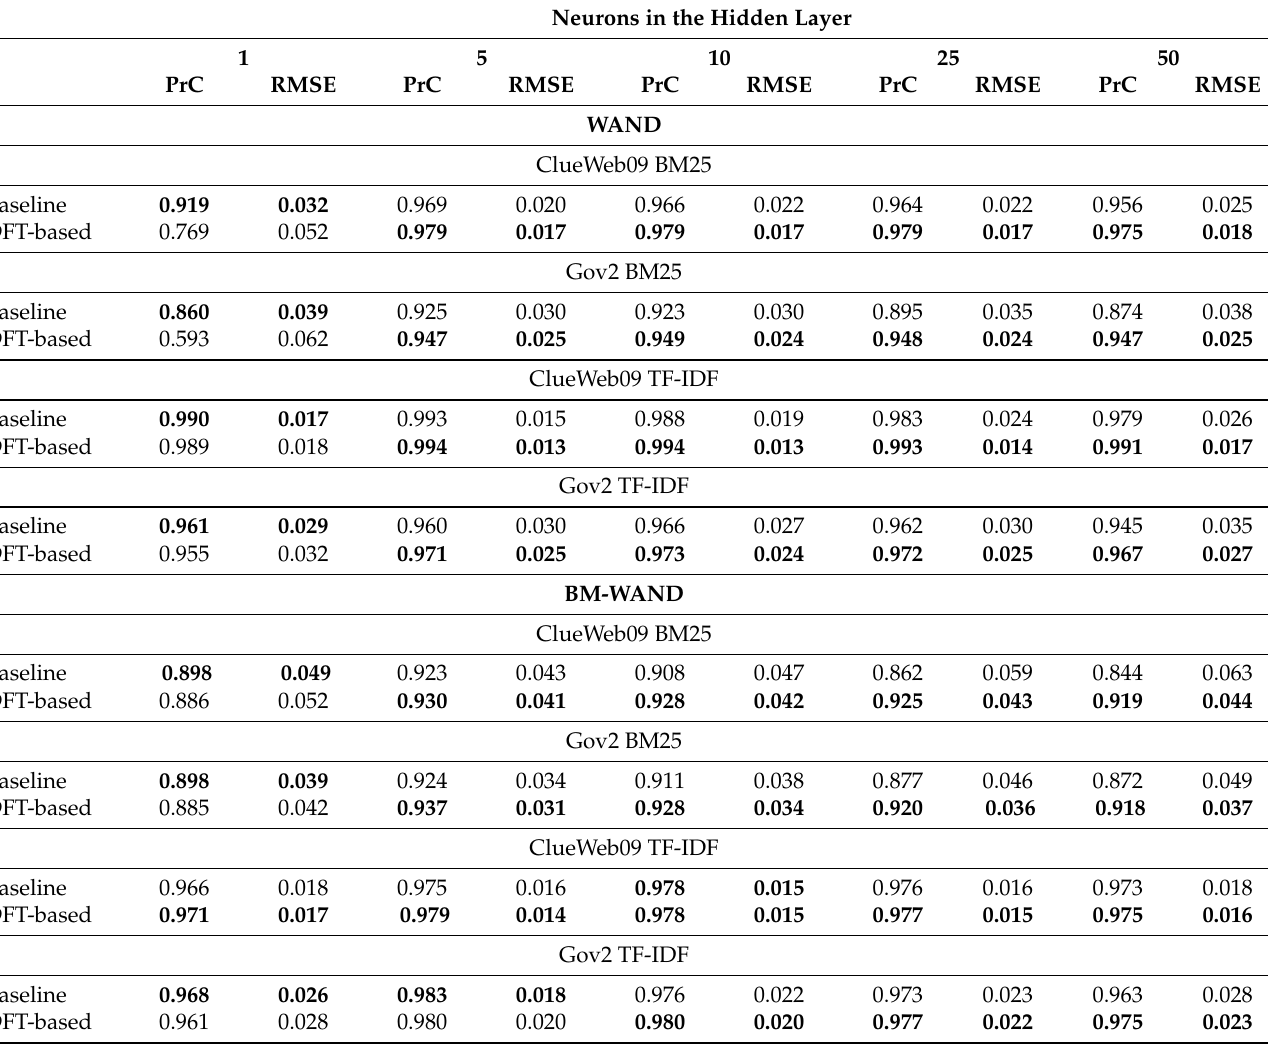
Table 4. Accuracy for a training fold of 60% and a test fold of 40% with 1,5,10,25 and 50 neurons in the hidden layer. Neurons in the Hidden